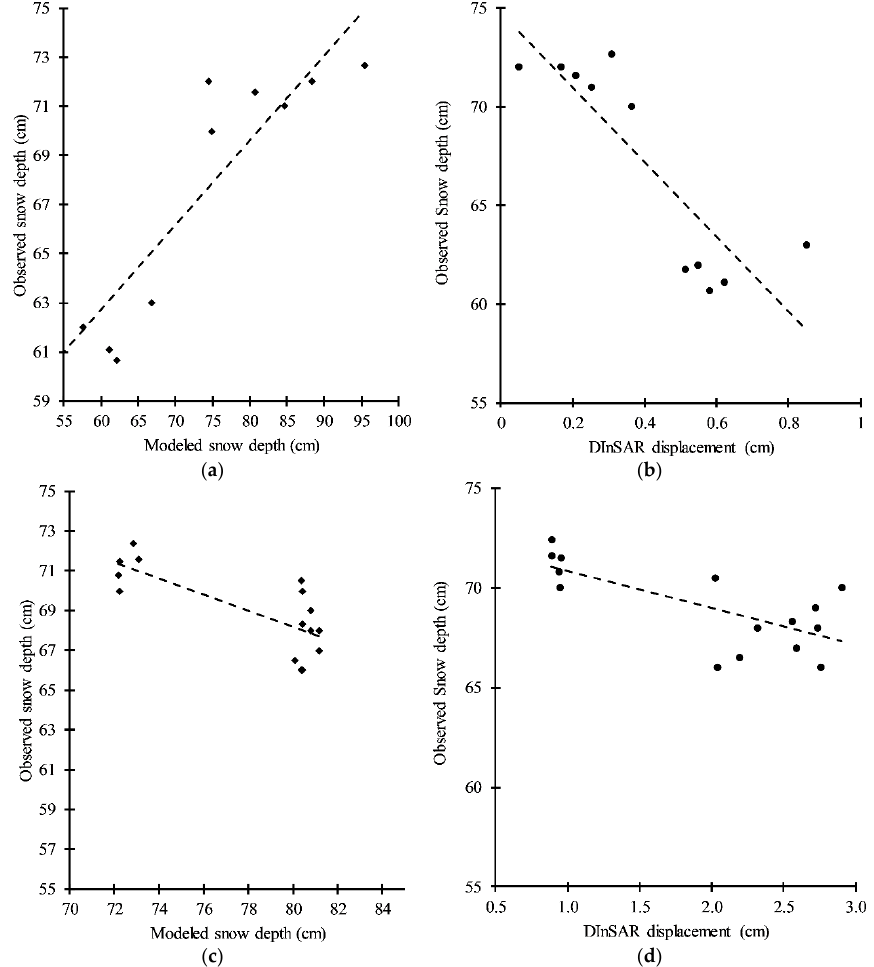
Figure 12. A comparison with respect to the field measurements for February and March 2019; modeled snow depth estimates using the proposed approach ( a , c ) and DInSAR based displacement ( b , d ), respectively.